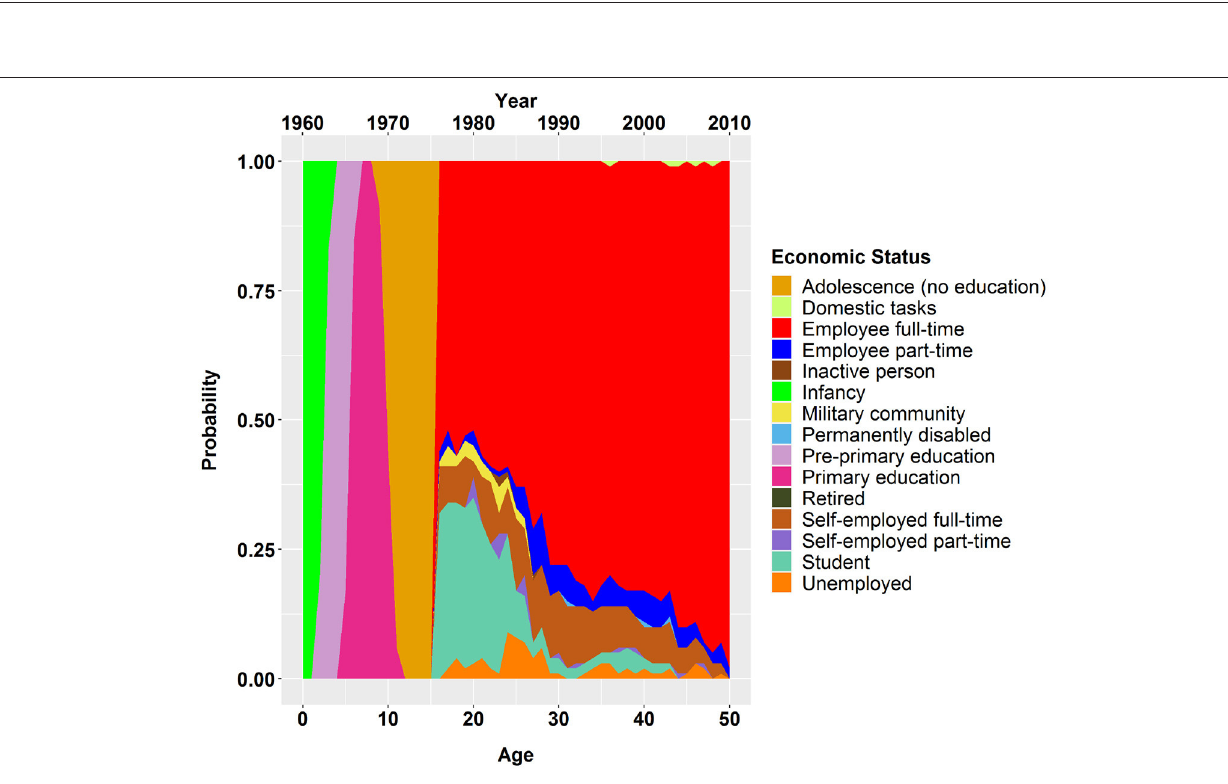
Frontiers in Public Health |